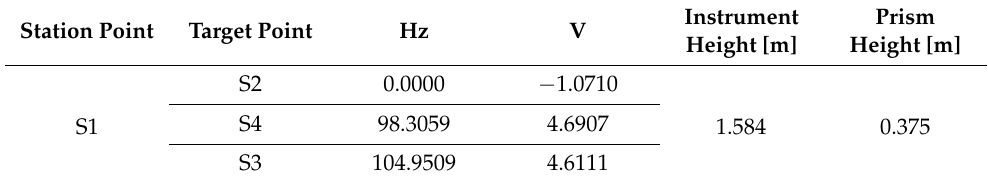
Table A9. The angular observations after 2 years